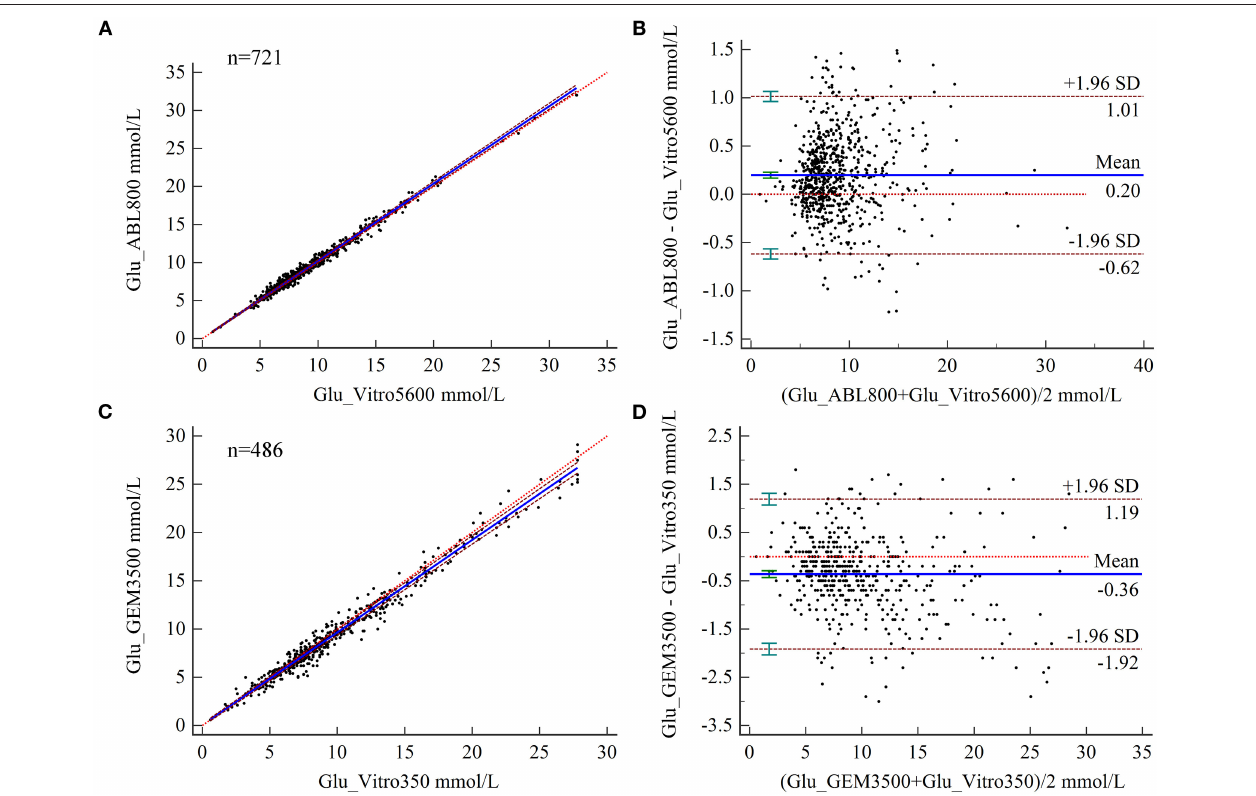
FIGURE 3 | (A,B) Scatter diagrams showing the results of Passing–Bablok regression analysis of the comparisons of glucose (Glu) levels in arterial blood and venous serum samples between the ABL800 FLEX and VITROS5600 systems (A) and between the GEM3500 and VITROS350 systems (B) . The graph shows the observations together with the regression line (solid blue line), the confidence interval for the regression line (dashed lines), and the identity line ( x = y , dotted line). (C,B) Results of Bland–Altman analysis comparisons of Glu levels in blood and venous serum samples between the ABL800 FLEX and VITROS5600 systems (C) and the GEM3500 and VITROS350 systems (D) , showing the 95% limits of agreement (LoA). The scatter diagrams show the differences plotted against the averages of the two measurements. Horizontal lines are drawn at the mean difference and the